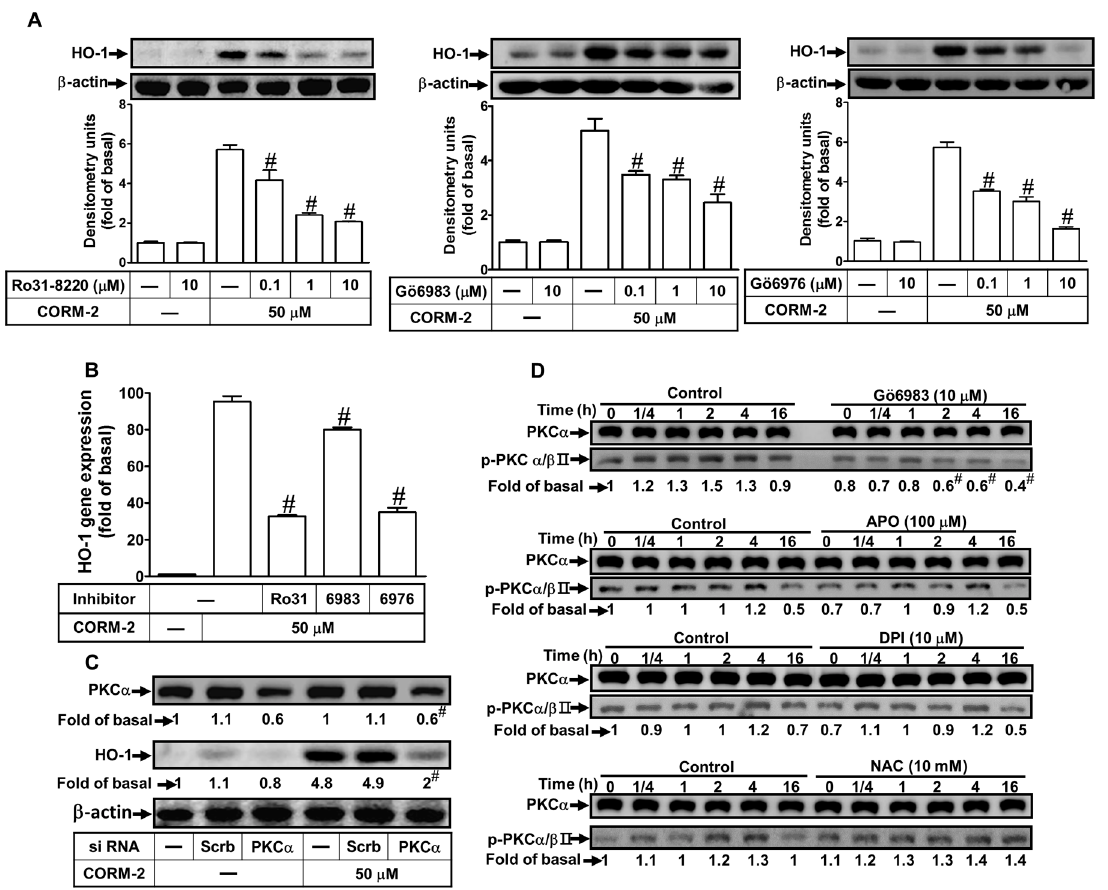
Figure 4. CORM-2 induces HO-1 expression via a PKC α -dependent pathway in HTSMCs. ( A ) Cells were pretreated with Ro31-8220, Gö6983, or Gö6976 for 1 h, and then incubated with CORM-2 (50 µ M) for 24 h. The protein levels of HO-1 and β -actin (served as an internal control) were determined by Western blot. ( B ) Cells were pretreated with Ro31-8220 (10 µ M), Gö6983 (10 µ M), or Gö6976 (10 µ M) for 1 h, and then incubated with CORM-2 for 6 h. The mRNA expression of HO-1 was determined by real-time PCR. ( C ) Cells were transfected with either scrambled (Scrb) or protein kinase C (PKC α ) siRNA, and then incubated with CORM-2 for 24 h. The levels of PKC α , HO-1, and β -actin (served as an internal control) protein were determined by Western blot. ( D ) Cells were pretreated without or with Gö6983 (10 µ M), APO (100 µ M), DPI (10 µ M), or NAC (10 mM) for 1 h, and then incubated with CORM-2 for the indicated time intervals. The levels of phospho-PKC α and PKC α were determined by Western blot. Data are expressed as mean ± SEM of five independent experiments ( n = 5). # p < 0.05, as compared with the cells exposed to CORM-2 alone. Data analysis and processing are described in the section “Statistical Analysis of Data”.